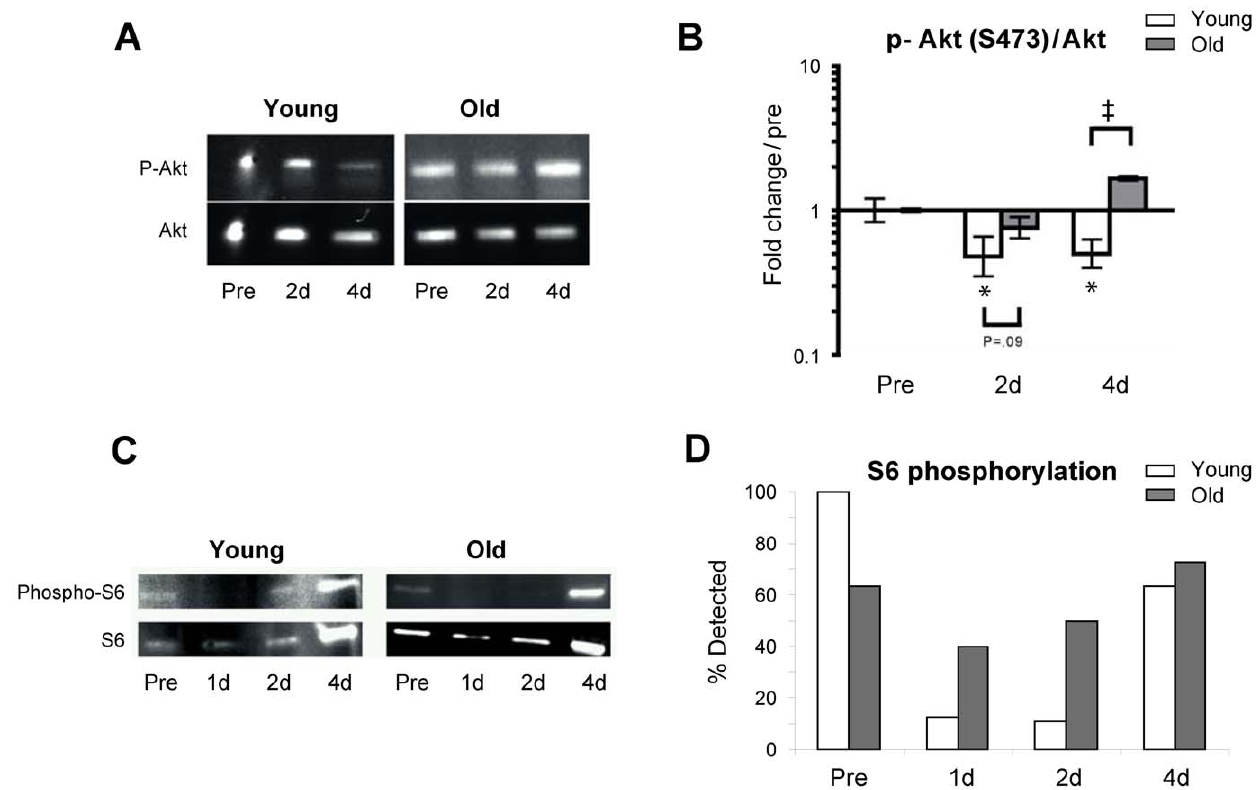
Figure 4. Immobility induced skeletal muscle atrophy results in an age-specific decrease in Akt and ribosomal protein S6 phosphorylation. A. Western blotting of whole muscle protein homogenates of phosphorylated Akt and total Akt. B. Immobility decreased levels of phosphorylated Akt/total Akt ratio (p-Akt/Akt) at the early (2–4 days) phase of immobility in young but not aged skeletal muscle. * Time effect, p , 0.05, compared to pre. # Age effect, p , 0.001 young compared to old within time point. Due to lack of muscle tissue n=6 (3 young and 3 old) in these analyses. C. Western blotting of whole muscle protein homogenates of total and phosphorylated S6 ribosomal protein. D. The percentage of the total number of subjects at each time point where p-S6 could be detected. Chi-square: Young p , 0.001, Old p=0.44. In a high number of especially young subjects phosphorylated S6 ribosomal protein (but not total S6 ribosomal protein) became non detectable after immobilization which made an exact quantification